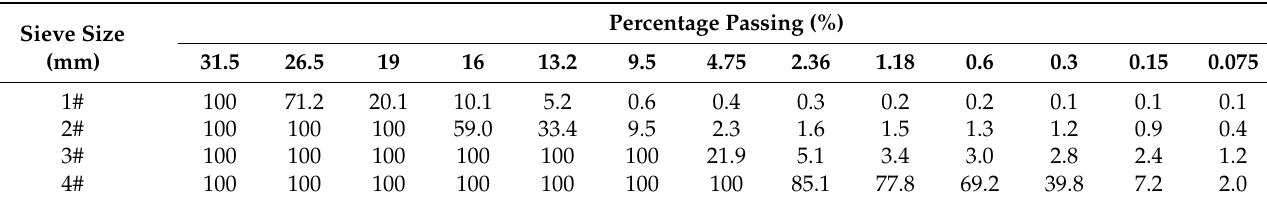
Table 2. Gradation of limestone aggregates.